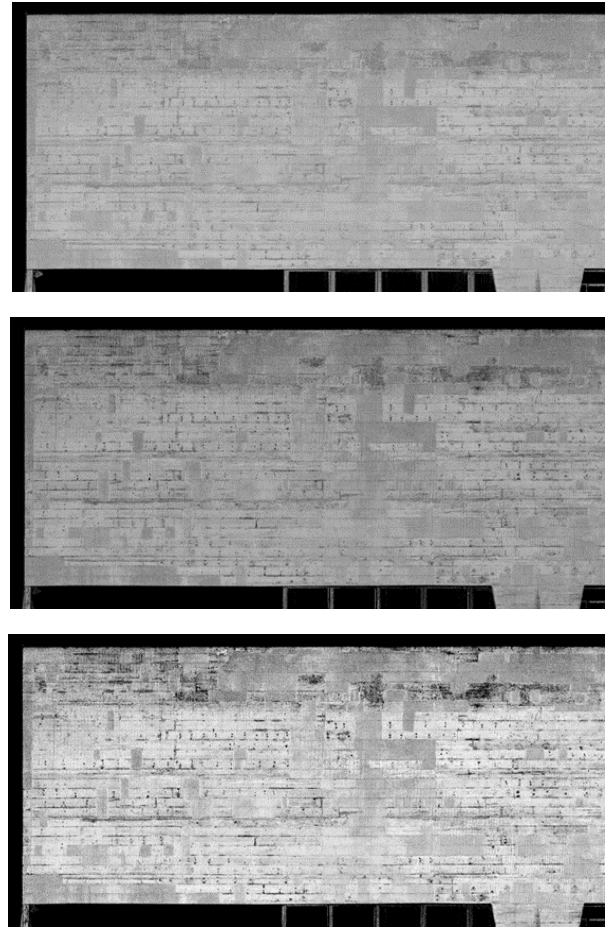
Figure 4. Greyscale visualization of a sample are of the point cloud